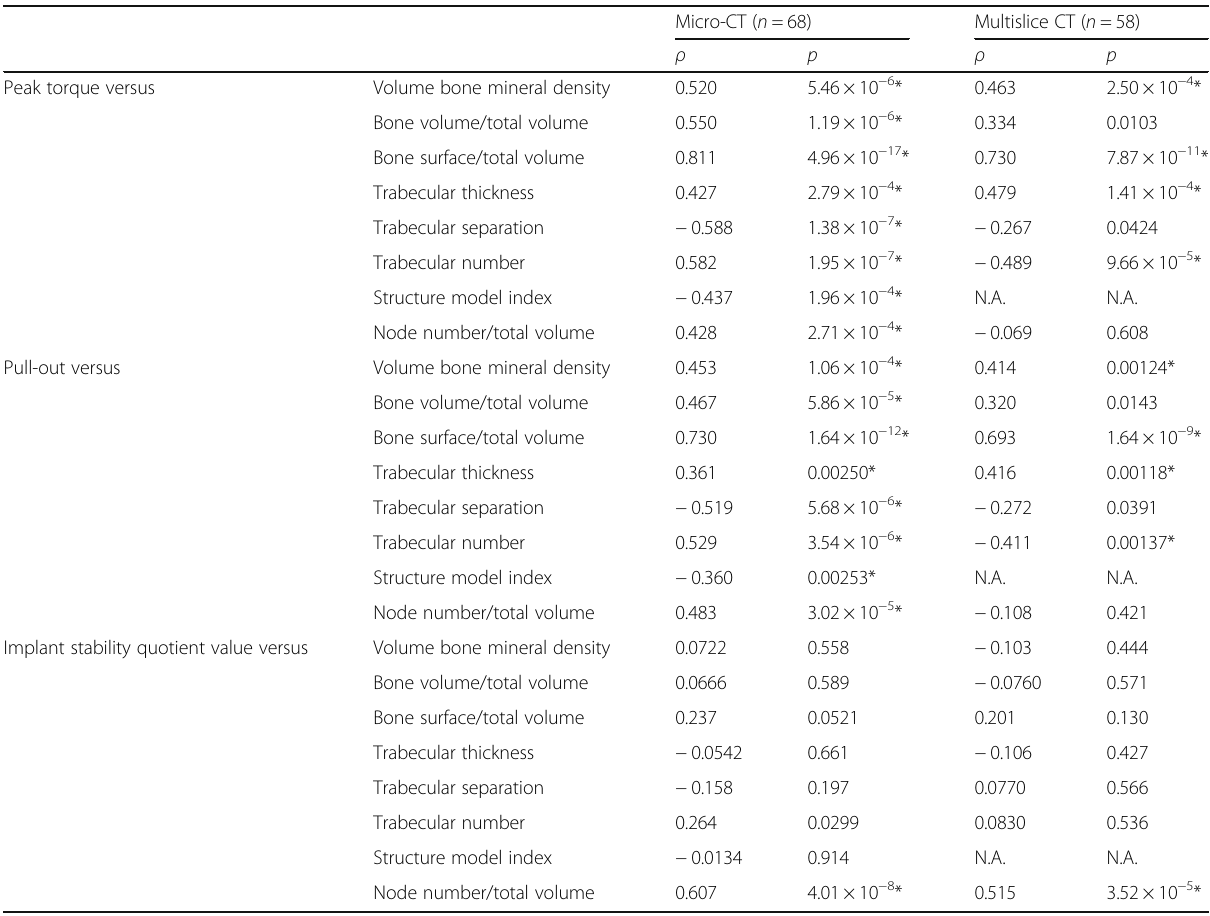
Table 2 Correlation coefficients and p values for the three test forces versus CT parameters on micro-CT and multislice